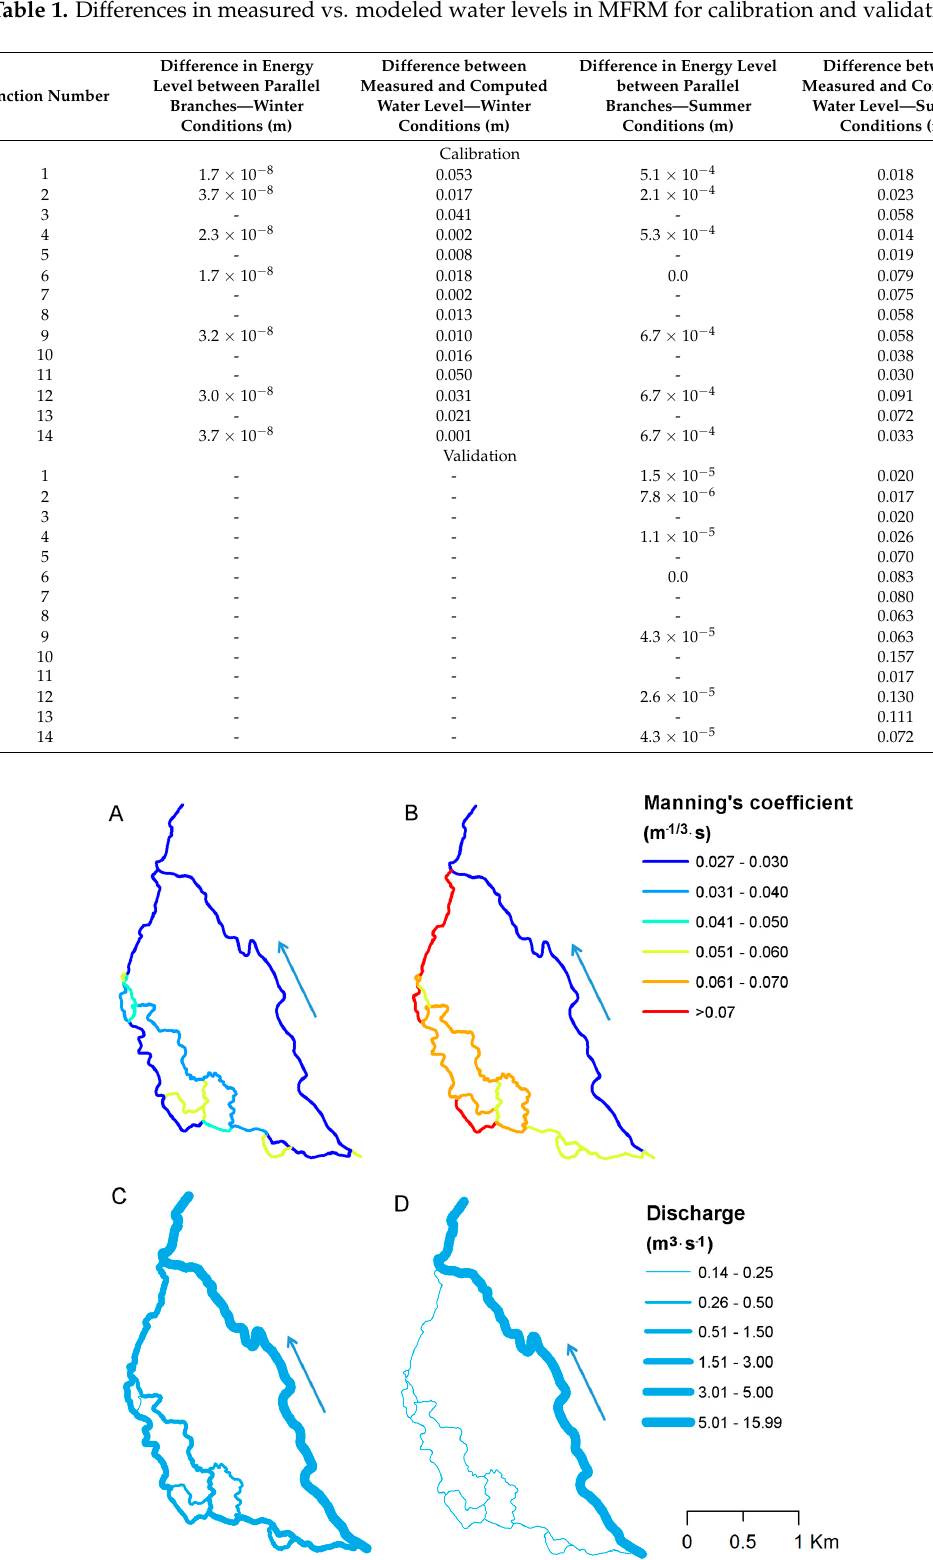
Table 1. Differences in measured vs. modeled water levels in MFRM for calibration and validation.